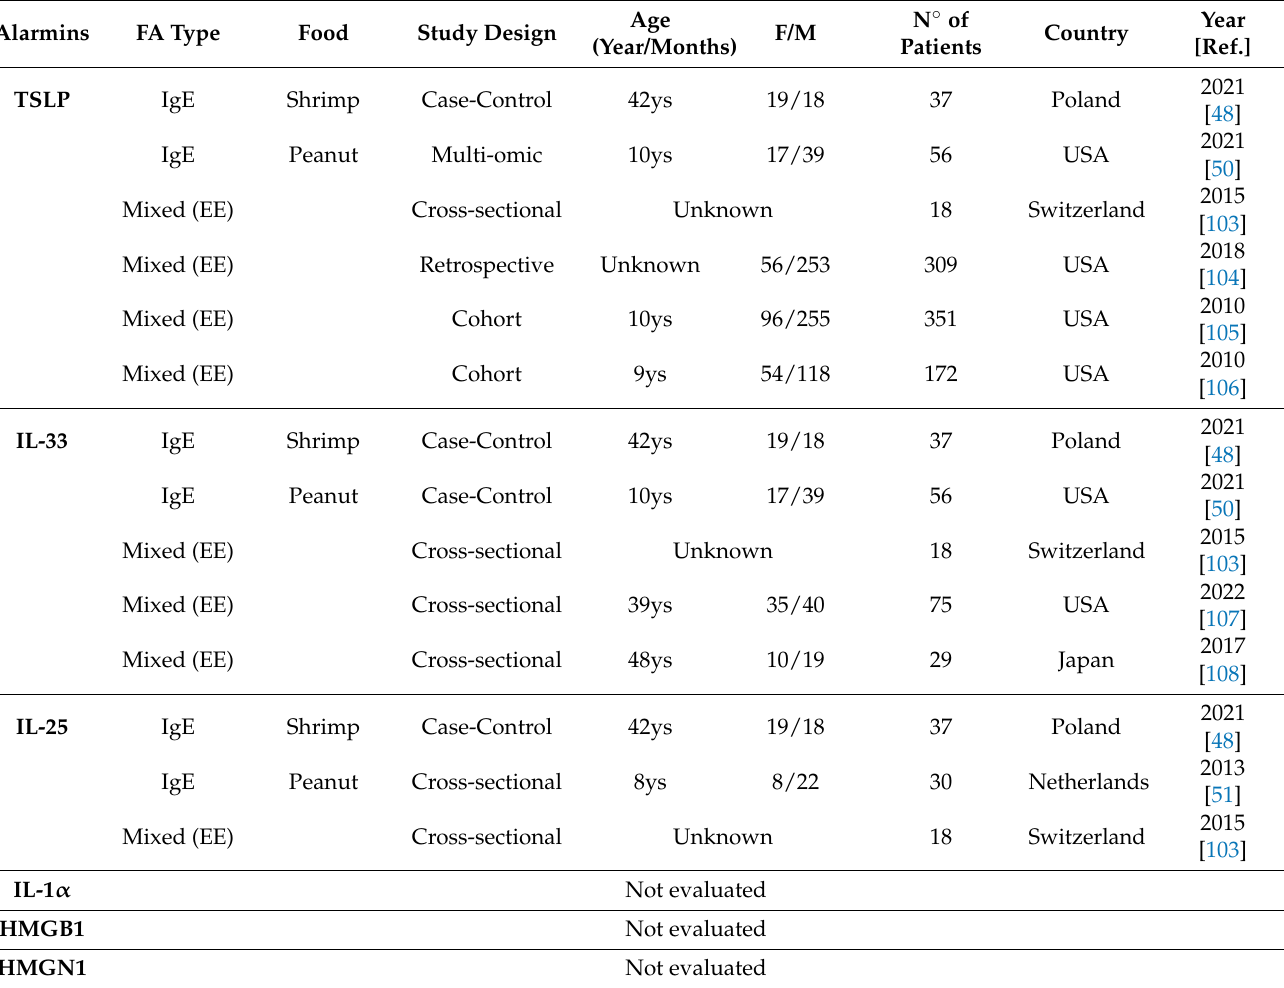
Table 1. Human studies on nuclear alarmins in food